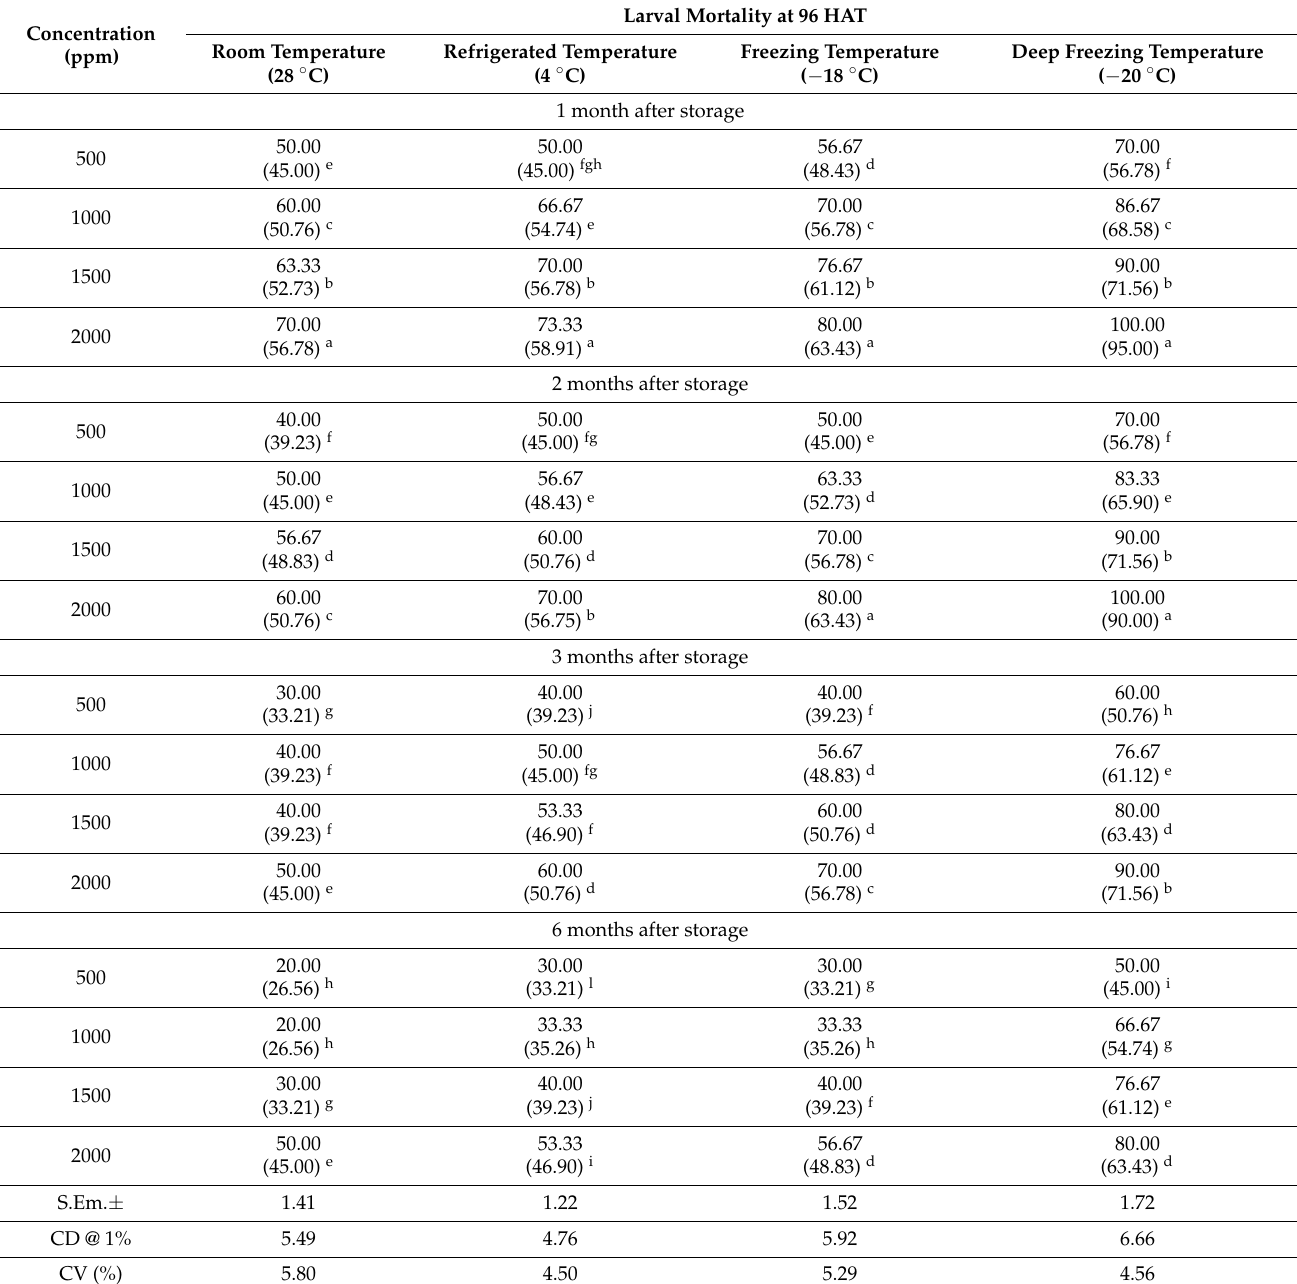
Table 3. Effect of A. indica -based AgNPs stored at different temperatures on the larval mortality of H. armigera (Instar